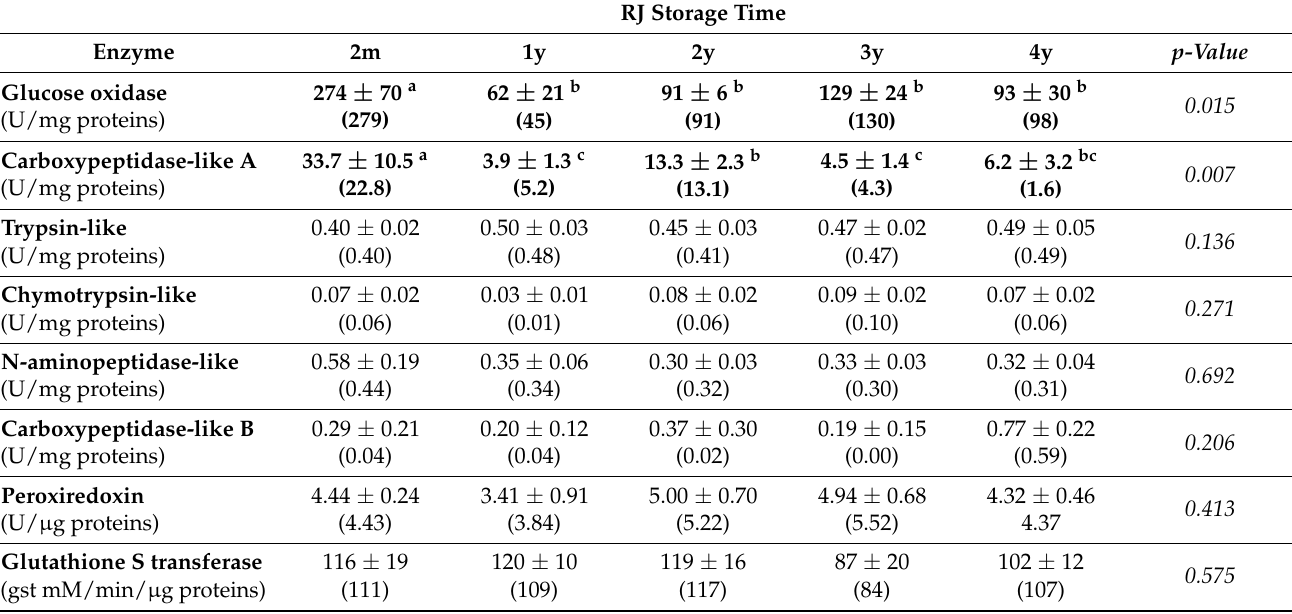
Table 2. Statistical differences of enzymatic activity in RJ samples stored for different period (2 months = 2m; 1 year = 1y; 2 years = 2y, 3 years = 3y and 4 years = 4y) at 4 ◦ C. Values are expressed as average ± SE (median). Significant differences are indicated with superscript different letters and marked in bold. RJ Storage Time